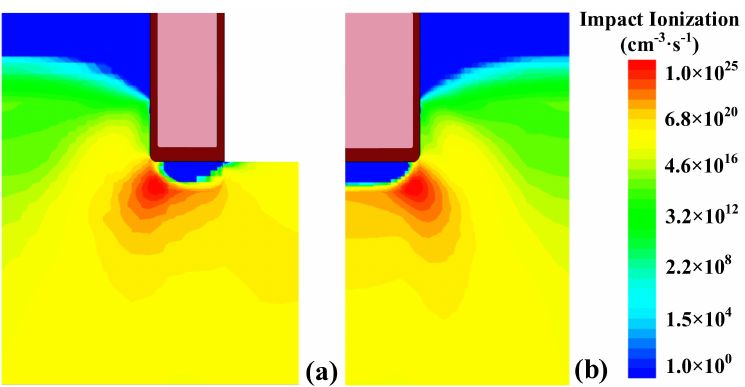
Figure 12. Impact ionization distribution inside ( a ) FS- and ( b ) C-TMOS at the time point T3. The key parameters of the two devices are summarized in Table 1. The unipolar device-level Figure of Merit [29] R on,sp · Q gd and R on,sp · Q g of FS-TMOS are almost the same and improved by 14% more than those of C-TMOS, respectively, validating advantage of comprehensive performance of FS-TMOS. Table 1. Characteristics of FS- and